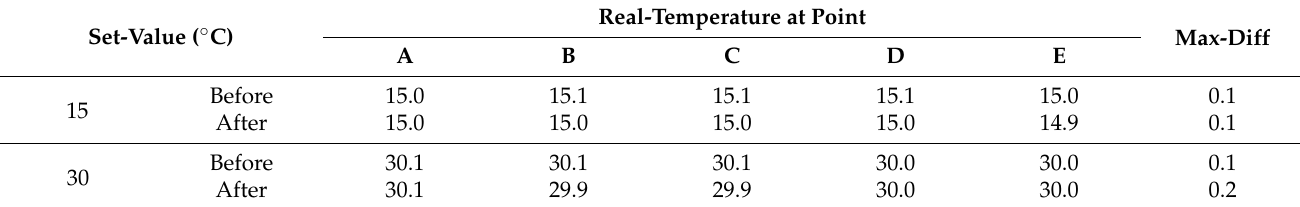
Figure 8. Temperature detection points on material. Table 3. The value of temperature detection points.